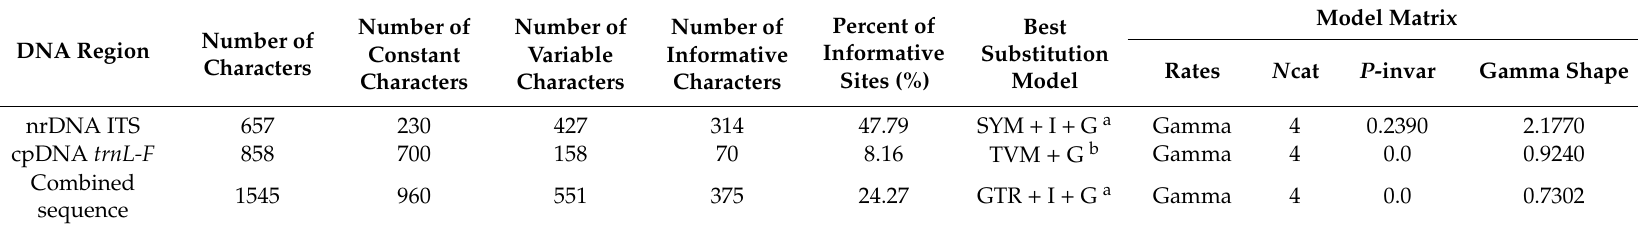
Table 1. Features of Nuclear ribosomal DNA (nrDNA) internal transcribed spacer (ITS) and chloroplast DNA (cpDNA) tRNA gene L region (trnL)- tRNA gene F region (trnL) intergenic spacer sequences of Blumea